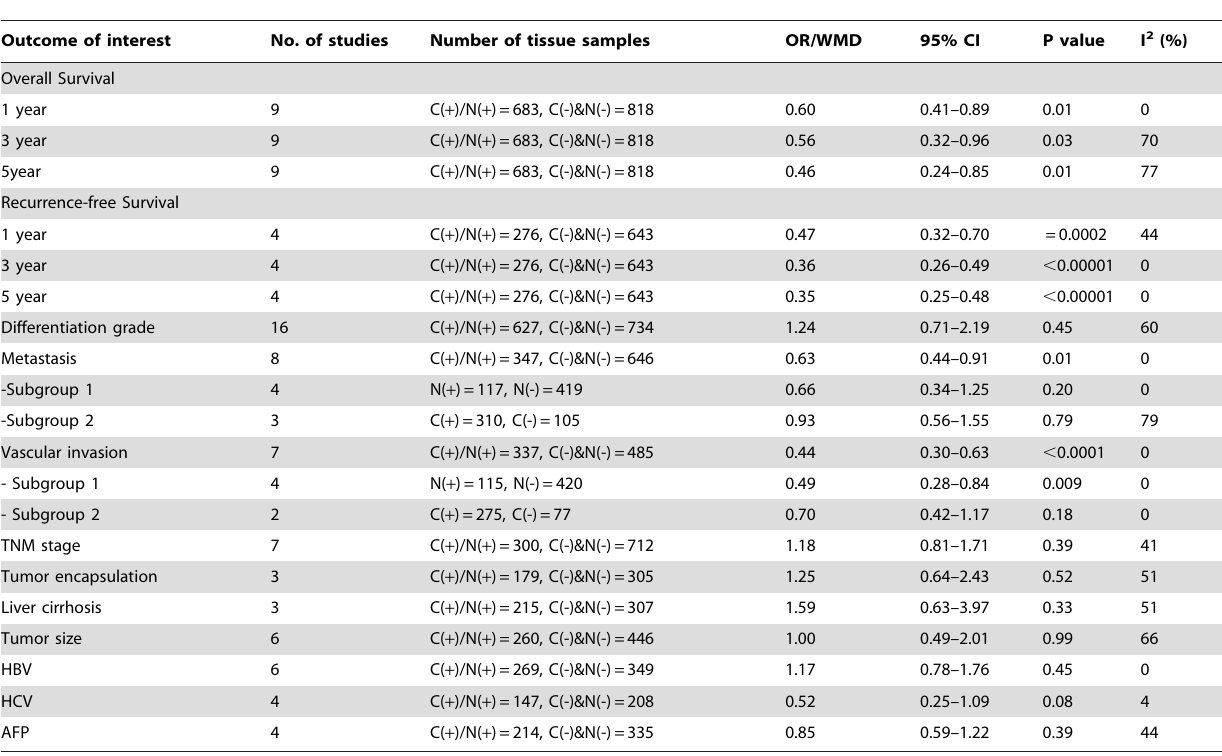
Table 4. Results of a meta-analysis comparing HCC with C/N b -catenin expression to M b -catenin expression.